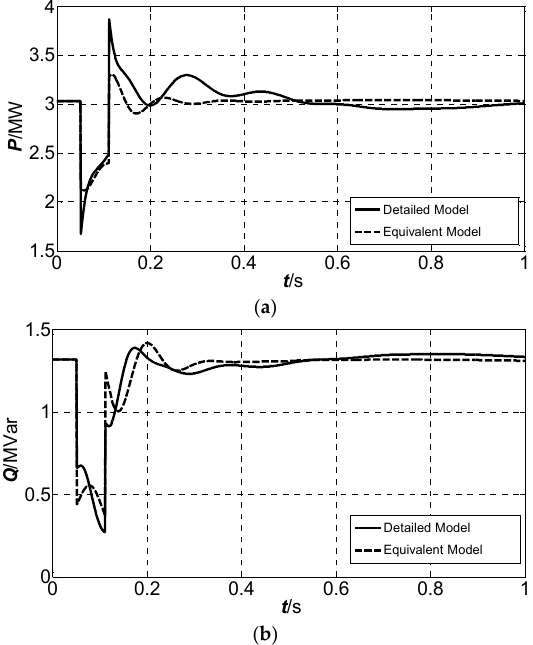
Figure 11. ( a ) The active power dynamics of the detailed model and the equivalent model under condition A; ( b ) The reactive power dynamics of the detailed model and the equivalent model under condition A.